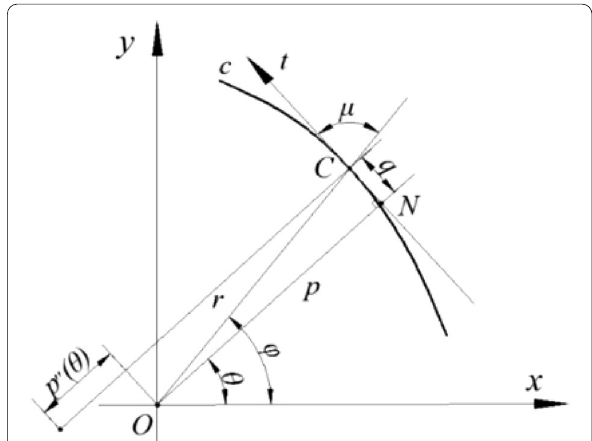
Figure 2 Curve and tangent in polar coordinates